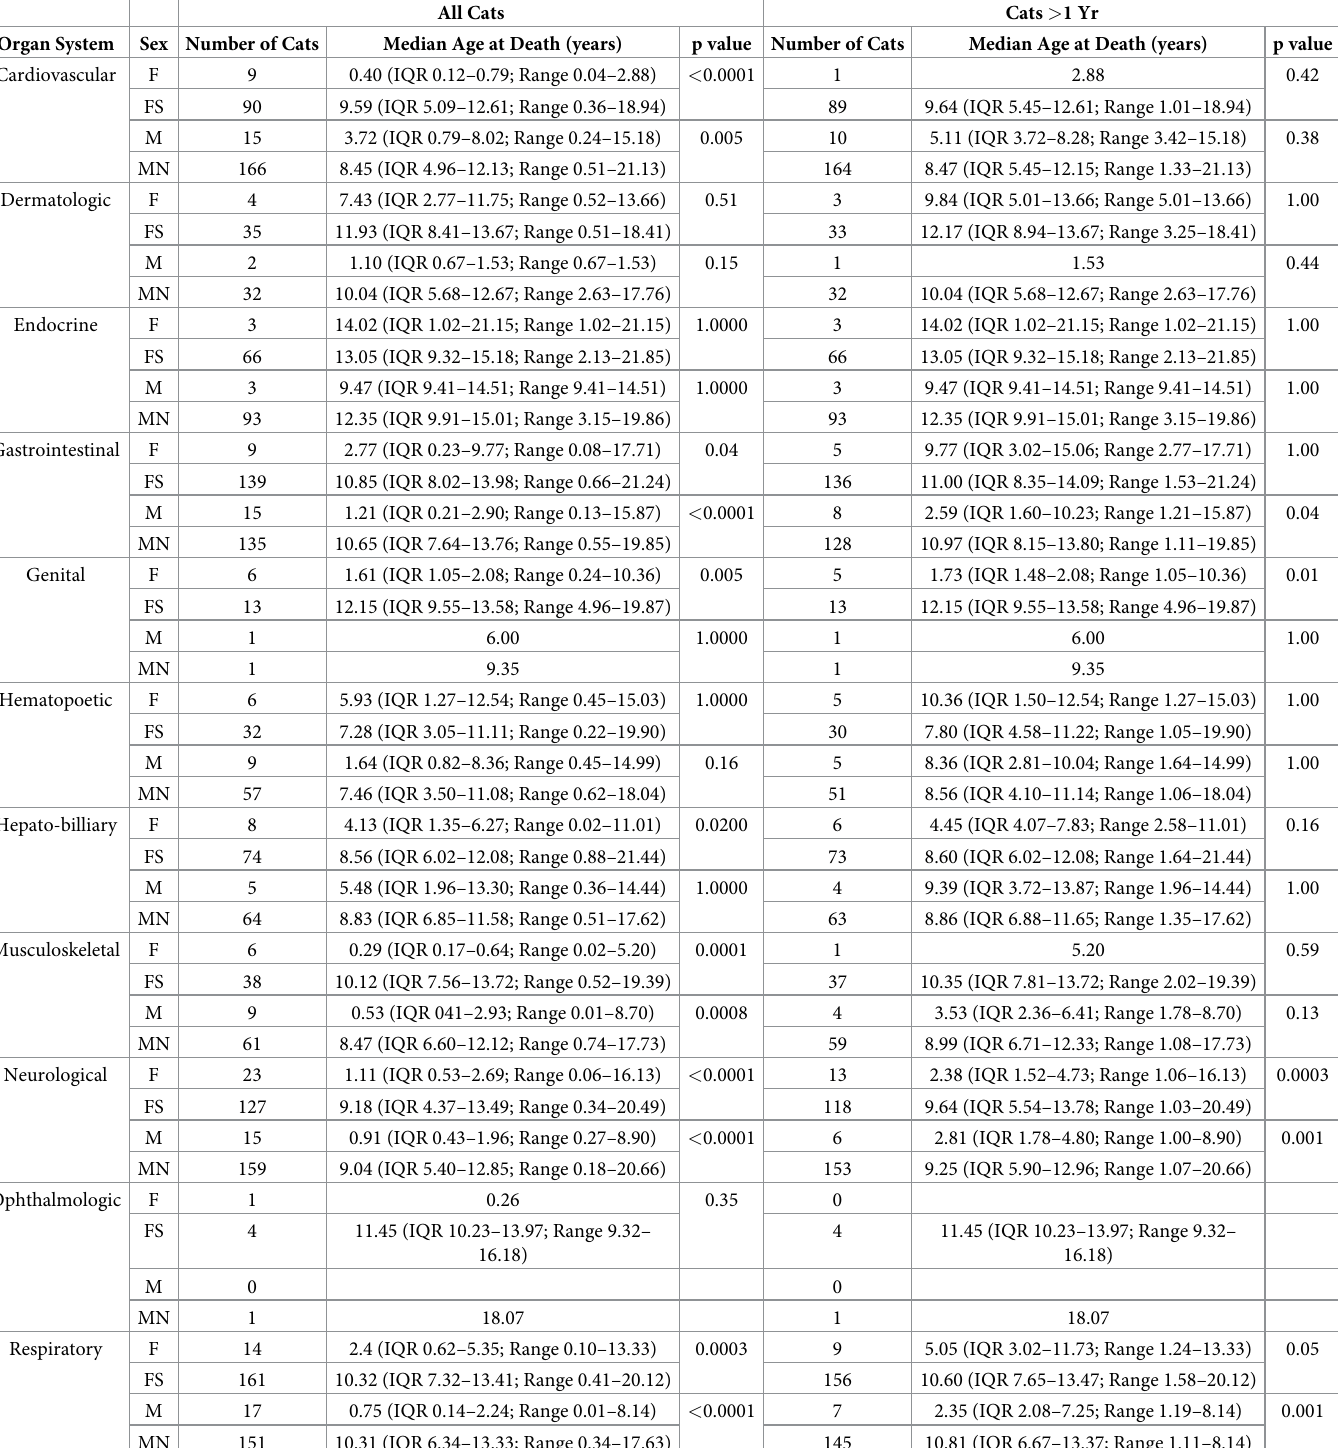
Table 5. Cause of death in all cats and cats � 1 year of age at the time of death categorized by organ system, sex and spay neuter